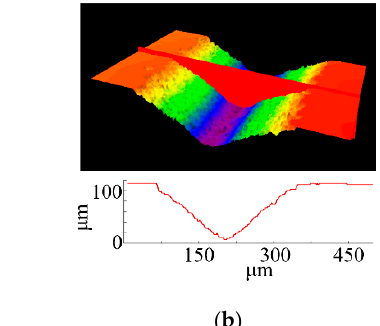
( a ) ( b ) Figure 12. Sample result of arbitrary scanning-mode patterning performed using the developed process: ( a ) convex circular pillar and ( b ) “HIT” characters. 5.2. Process Characterizations 5.2.1. Dependence of Machining Characteristics on the Pressure The widths of the linear patterns produced by lateral scanning of the Galinstan electrode were characterized while varying the pressure. The line widths of the produced patterns were measured using an optical measuring microscope. Figure 13 shows the relationship between the measured line widths and pressure (with V s = 100 V, C = 100 nF, R = 0.5 k Ω , as shown in Table 2). As shown in the graph, an optimal pressure value for the minimum line width was found under the same discharge conditions.